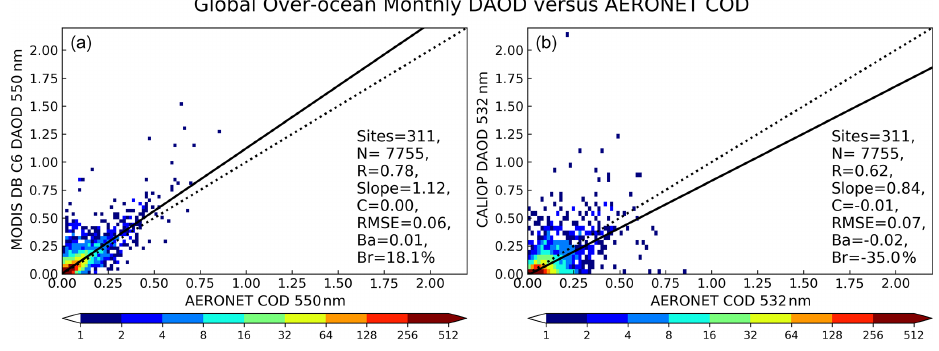
Figure 3. The same as Fig. 1 except for over the ocean.